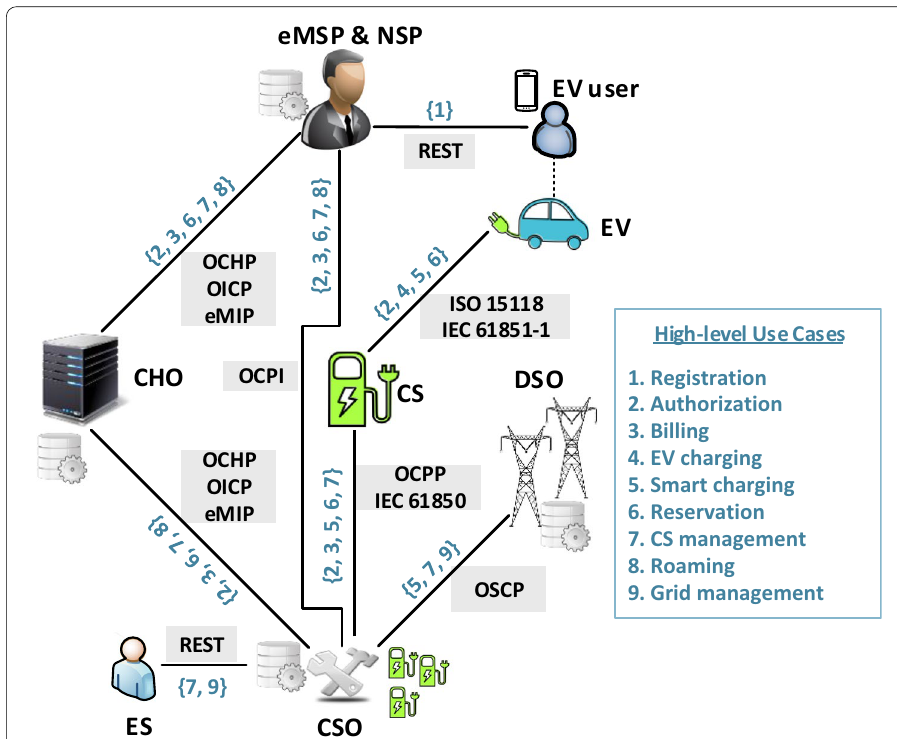
Fig. 3 Interactions among primary actors within the EV ecosystem: The actors (yellow squares) are depicted together with the data they exchange (blue arrows) as well as the corresponding standards (black arrows). Legal interactions are depicted by dashed black lines for the sake of